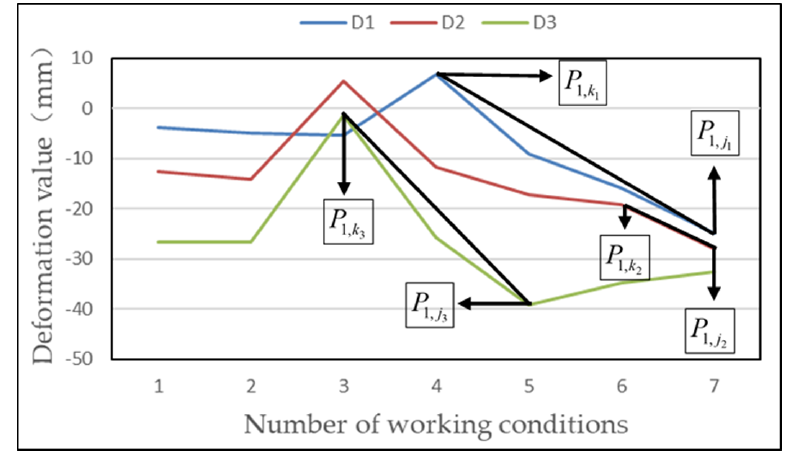
(12) Using the above example as an illustration, Figure 5 is a simple schematic diagram,